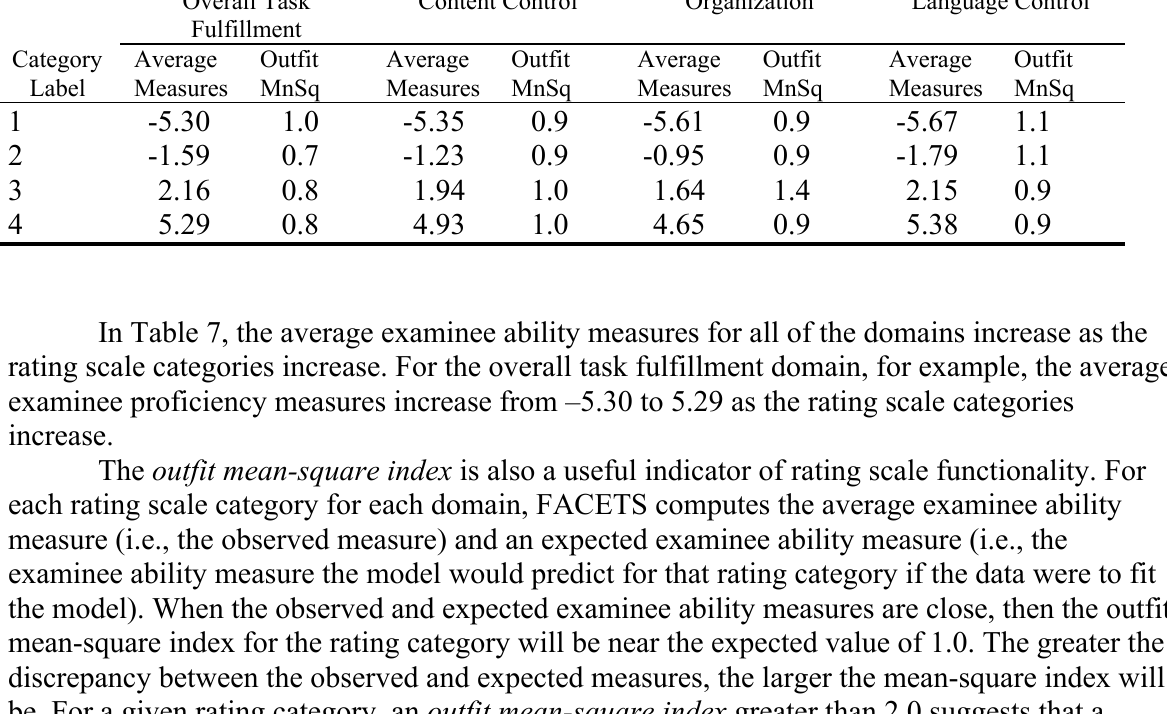
Average Examinee Ability Measures and Outfit Mean-square Indices from the FACETS Output Domain Overall Task Content Control Organization Language Fulfillment